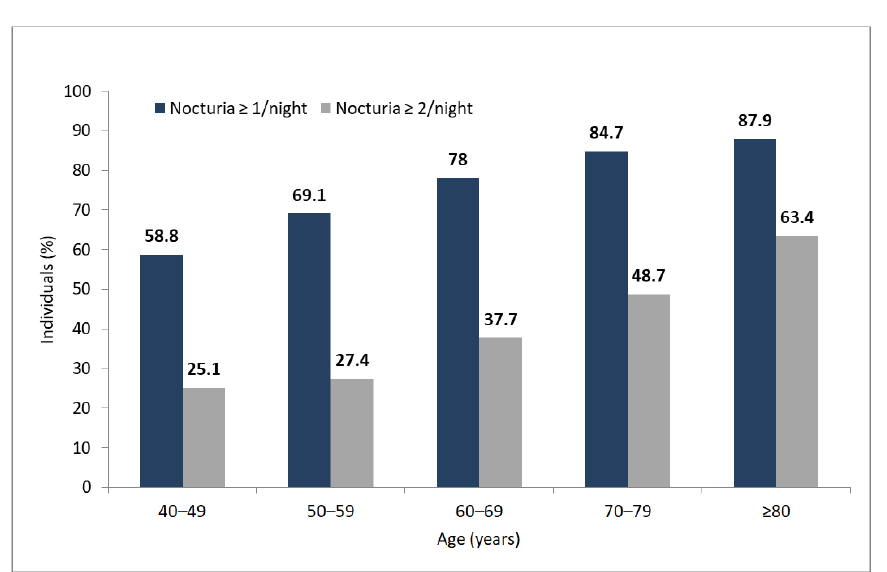
Figure 2. Prevalence of nocturia in age groups based on the two thresholds: nocturia ≥ 1 episode, and nocturia ≥ 2 episodes.